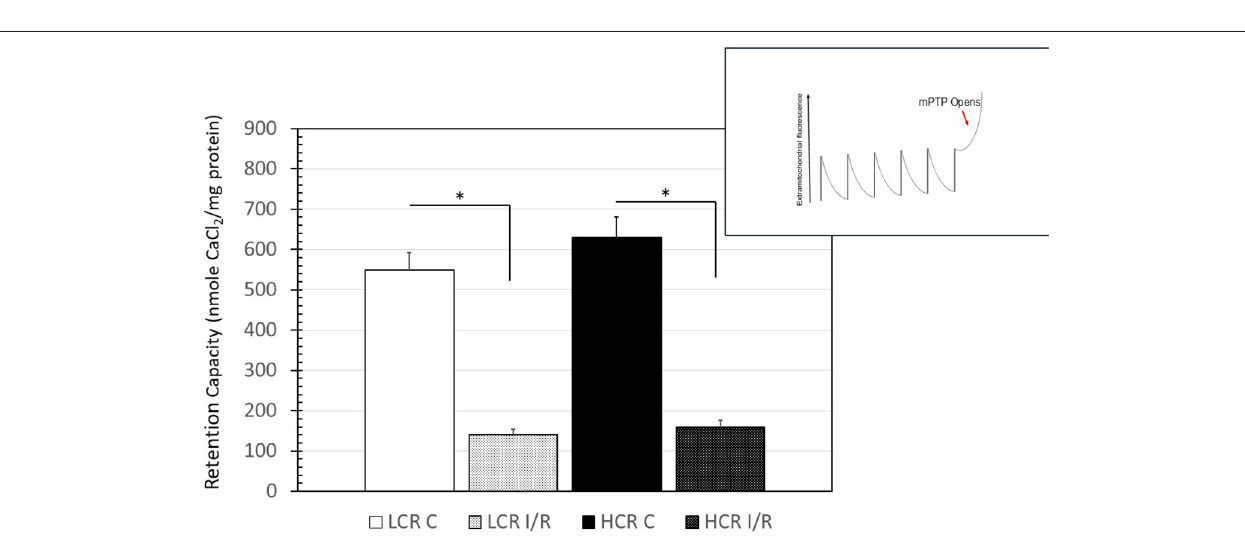
FIGURE 8 | Summary of results for the calcium-retention experiments. Inset is a representation of the tracings obtained, while the chart is a graphical summary of the group data. Arrow in inset indicates the change in calcium uptake that occurs when the transition pore opens. Data are expressed as mean ± SD. n = 8 per group for controls and 9 per group for IR. * p < 0.05 in designated